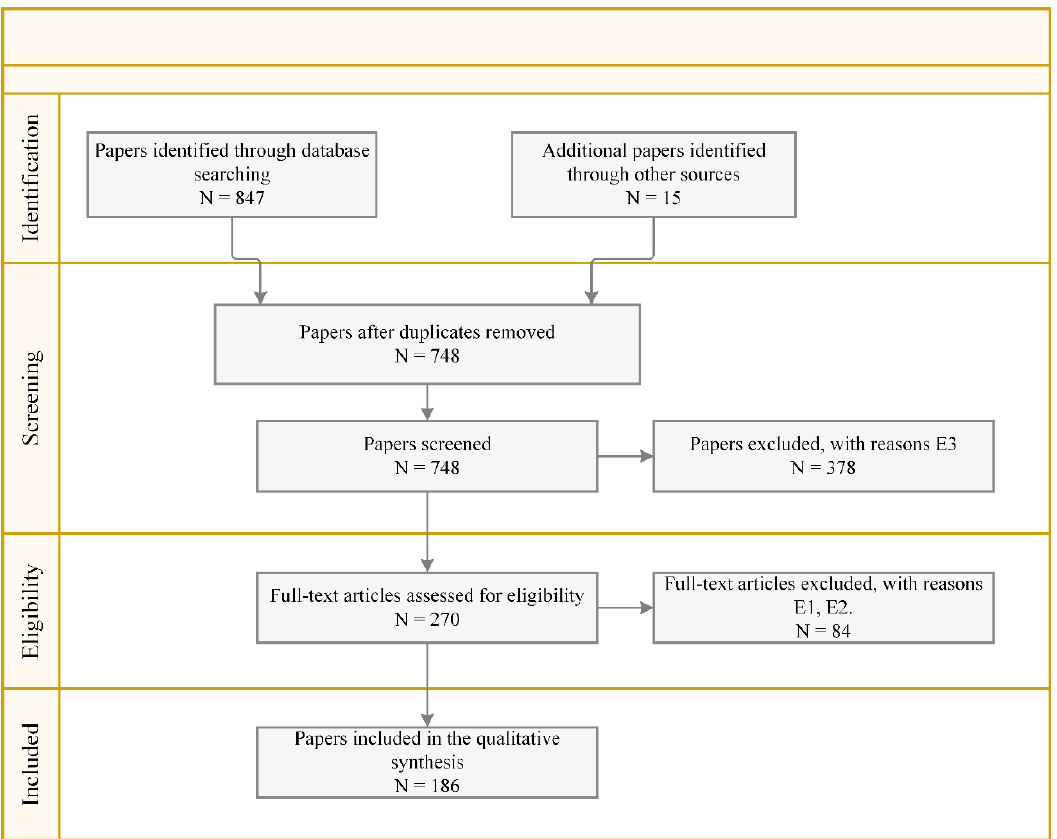
Figure 1. Preferred reporting items for systematic review and meta-analysis (PRISMA) flow chart.